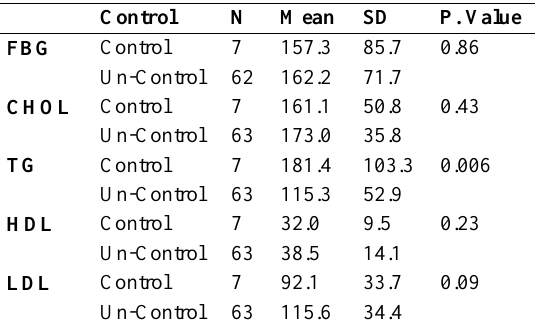
Table 4: FBG and Lipid profiles in diabetic patients according to